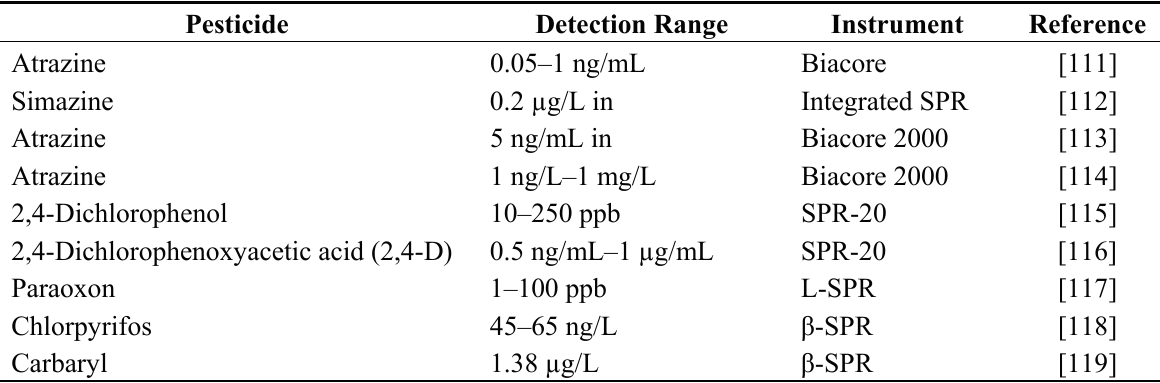
Table 2. SPR biosensors in pesticide